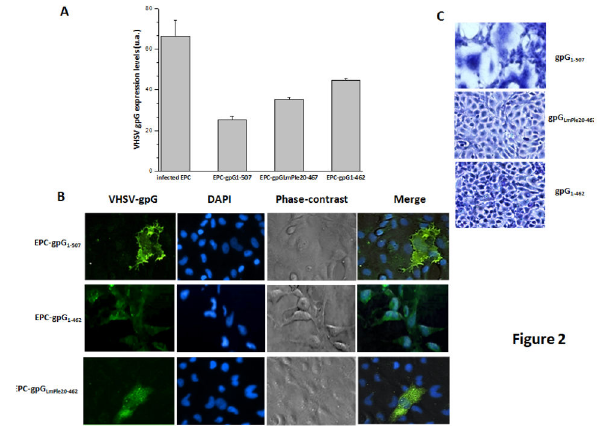
Figure 2. Characterisation of the VHSV-gpG protein forms expressed by the stably transfected EPC cell lines. Fresh EPC cell monolayers were co-transfected with each of pAE6-G , pAE6-G and pAE6-G , and pAE6-pac (puromycin 1-507 1-462 LmPle20-462 resistance gene). After an incubation period with puromycin, the remaining cells were screened for the expression of the different constructs by qPCR (A) and immunofluorescence (B). A, Data shows the transcript levels of each VHSV-gpG construct as well as those of VHSV-infected EPC cells. B, Cells were stained using a cocktail of anti-gpG MAbs and fluorescein isothiocyanate (FITC)- labeled anti-mouse IgG Ab. EPC-gpG monolayers were fixed with citofix and the EPC-gpG and EPC-gpG 1-507 LmPle20-462 1-462 monolayers permeabilised with 0,02% of PBS-Triton X.(C)To evaluate the functionality of the VHSV-gpG expressed by the transfected cells, a low pH-dependent fusion assay was performed. Cells were fixed with cold methanol, dried and stained with Giemsa (5 mg/ml in